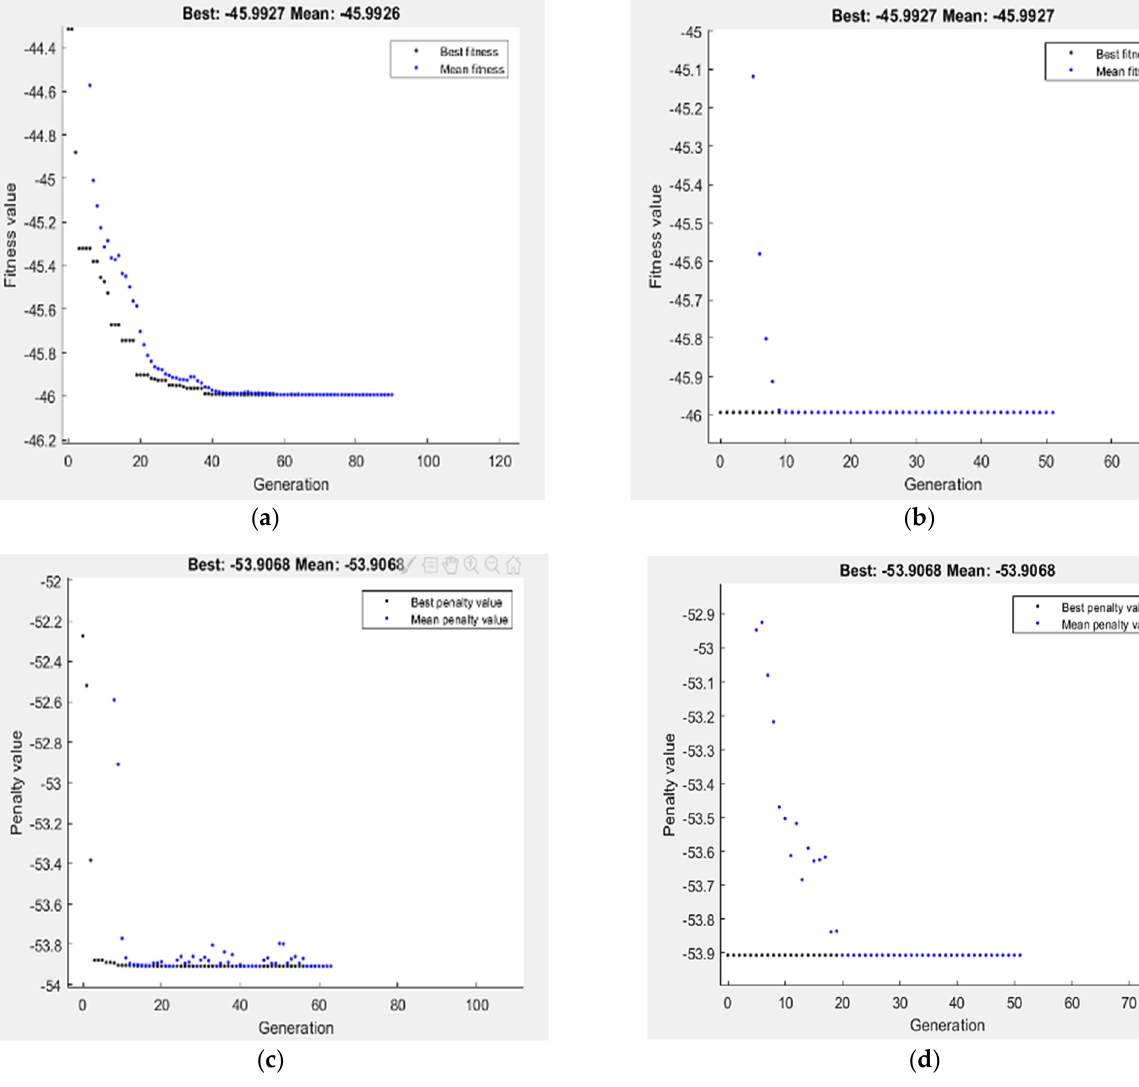
Figure 17. Optimum H C ( a , b ), and H E ( c , d ) by GA ( a , c ), and hybrid RSM-GA ( b , d ).